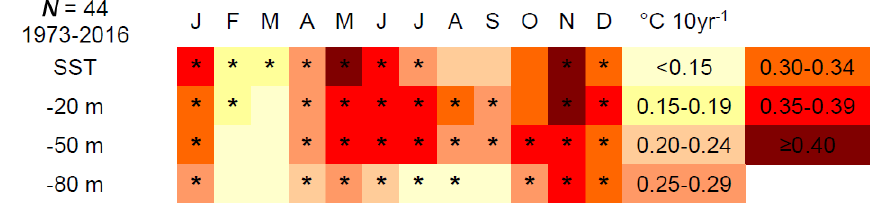
Figure 10. Scatter plot of the monthly relationship between the WeMOi value differences (1984–2016 minus 1951–1983) and sea temper- ature (ST) trends during the 1973–2016 period at surface (SST; a ), 20mb.s.l. (b) , 50mb.s.l. (c) and 80mb.s.l. (d) . A dashed line indicates the linear regression. Table 2. Monthly sea temperature trends at surface (SST), 20, 50 and 80mb.s.l. during 1973–2016 ( ∗ statistically significant trends at the 95% confidence level by means of the Mann–Kendall non-parametric